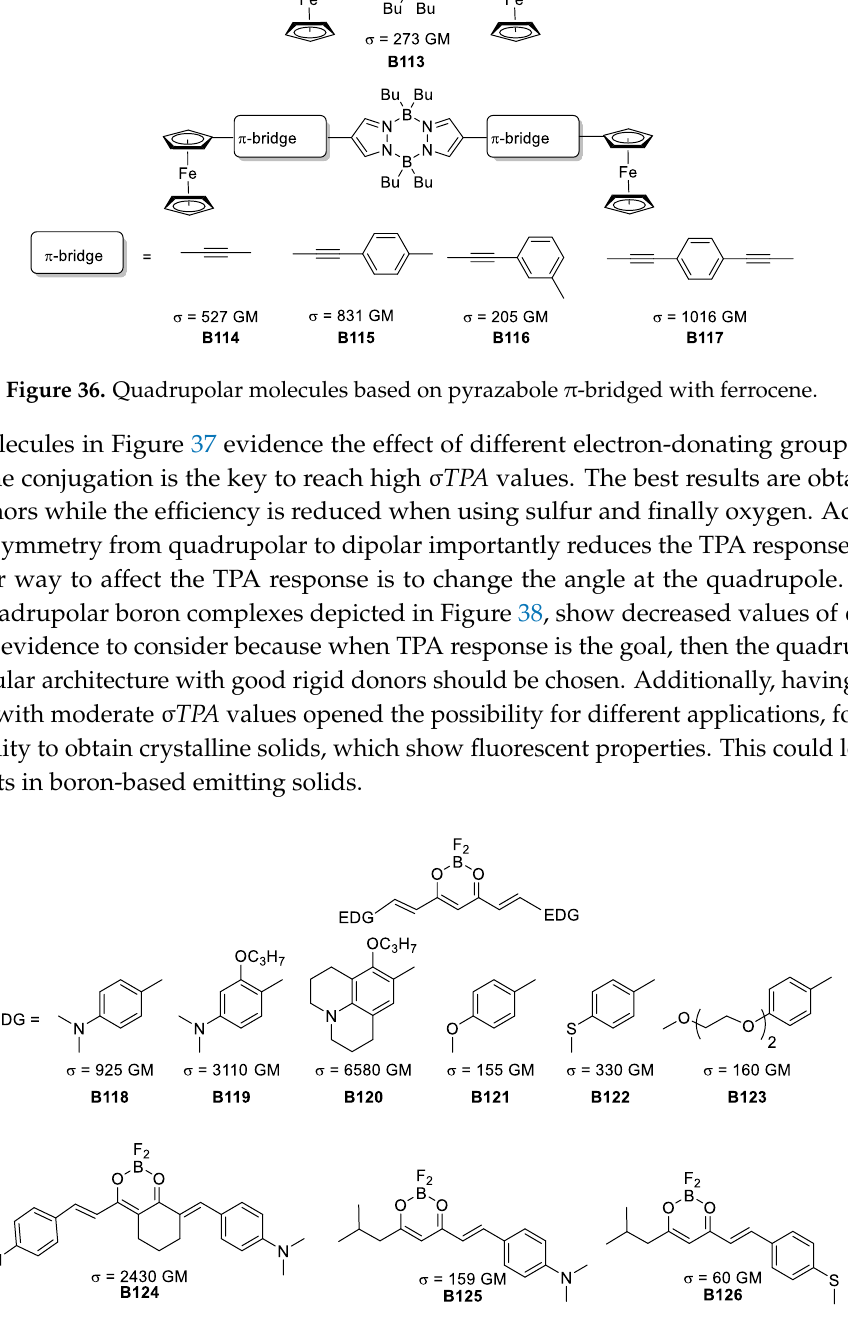
Figure 35. BF 2 -based, hydrazine-coordinated species of quadrupolar architecture presenting TPA.